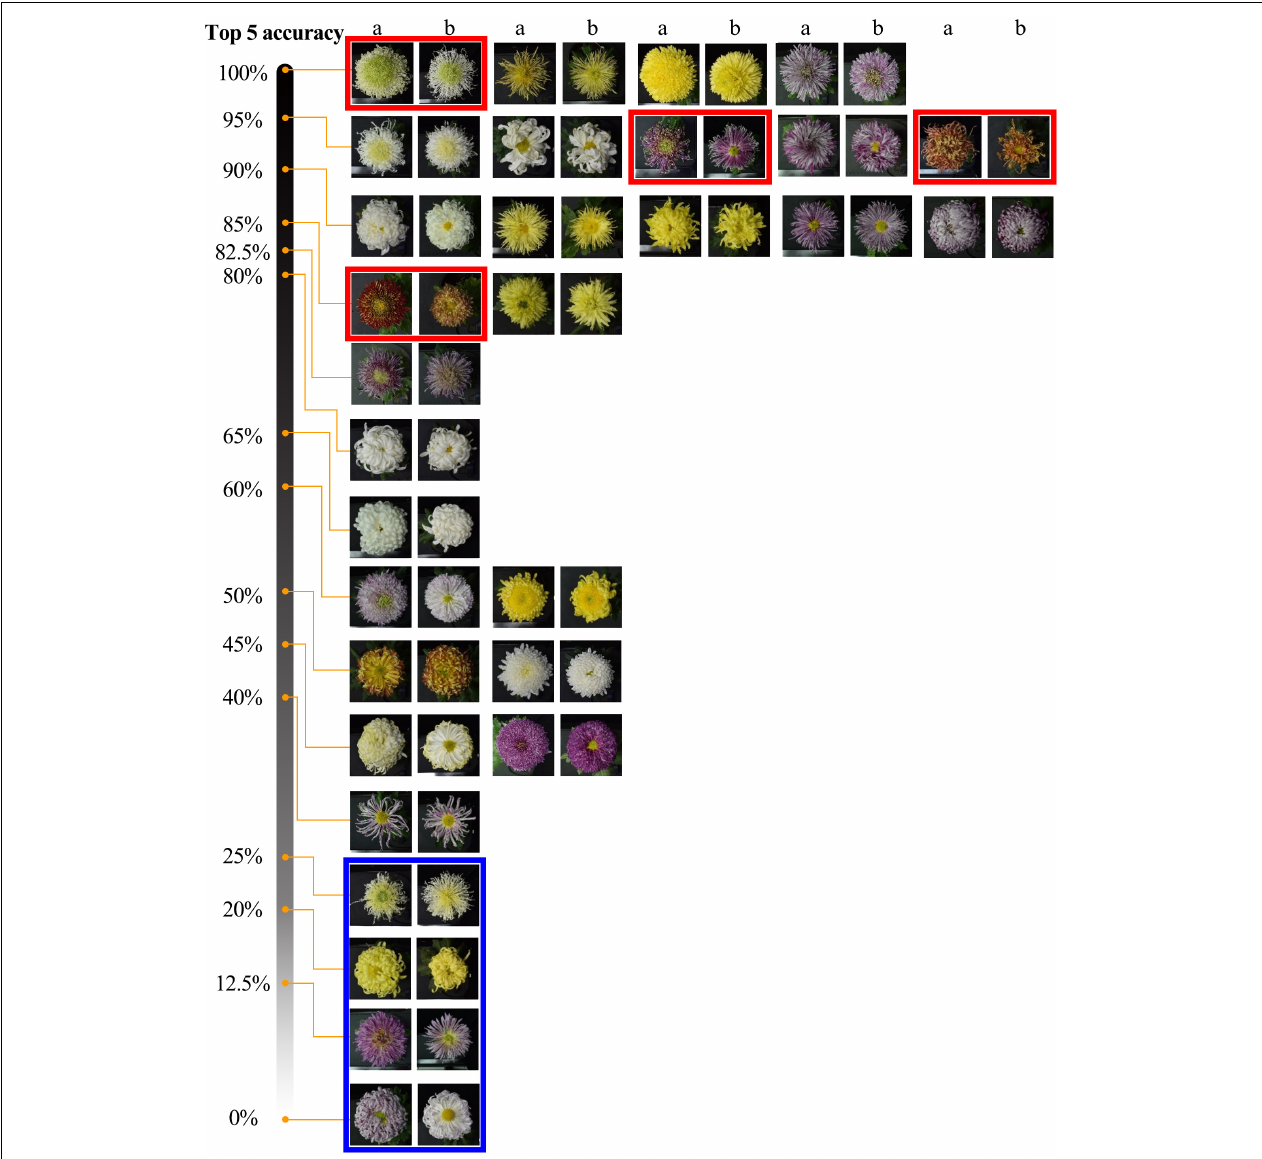
FIGURE 8 | Top-5 recognition results of 2019 dataset. The two adjacent columns are the same cultivar, a and b belong to the 2019 and 2018 datasets. Red and blue frames indicate some cultivars with noticeable morphological changes but with high and low identification accuracy.